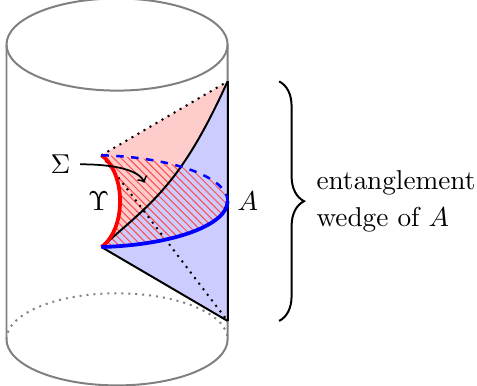
Figure 1. The entanglement wedge of a boundary subregion A is de(cid:12)ned as the domain of de- pendence of a partial Cauchy surface (cid:6) interpolating between A and its associated HRT surface (cid:7). (The colour scheme here will be used throughout this paper. Blue colouring indicates something on the boundary, whereas red colouring indicates something in the